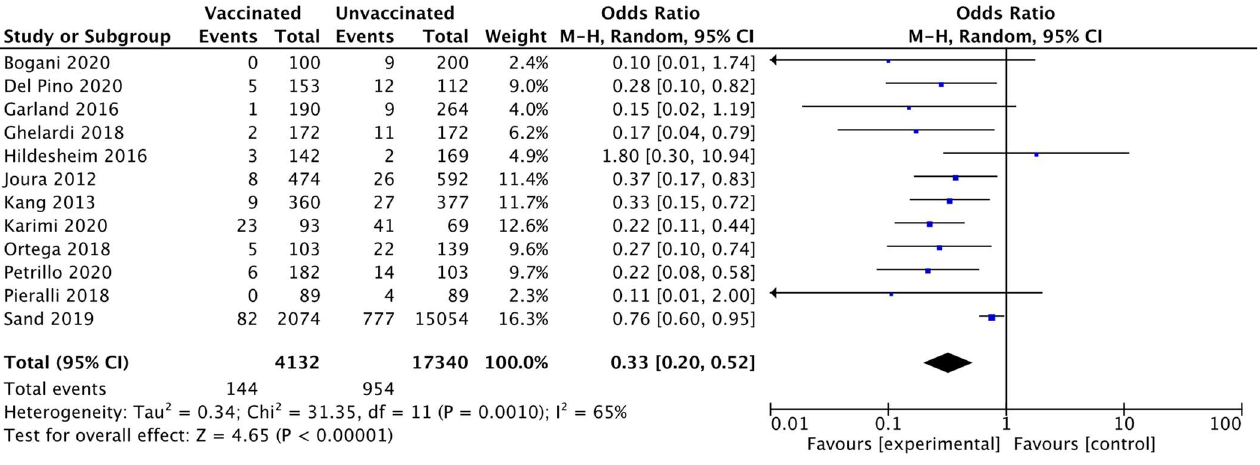
Figure 2. ( A ) Risk of bias summary: authors’ judgments about each risk of bias item for each in- cluded study. ( B ) Risk of bias graph: authors’ judgments about each risk of bias item presented as percentages for all included studies.